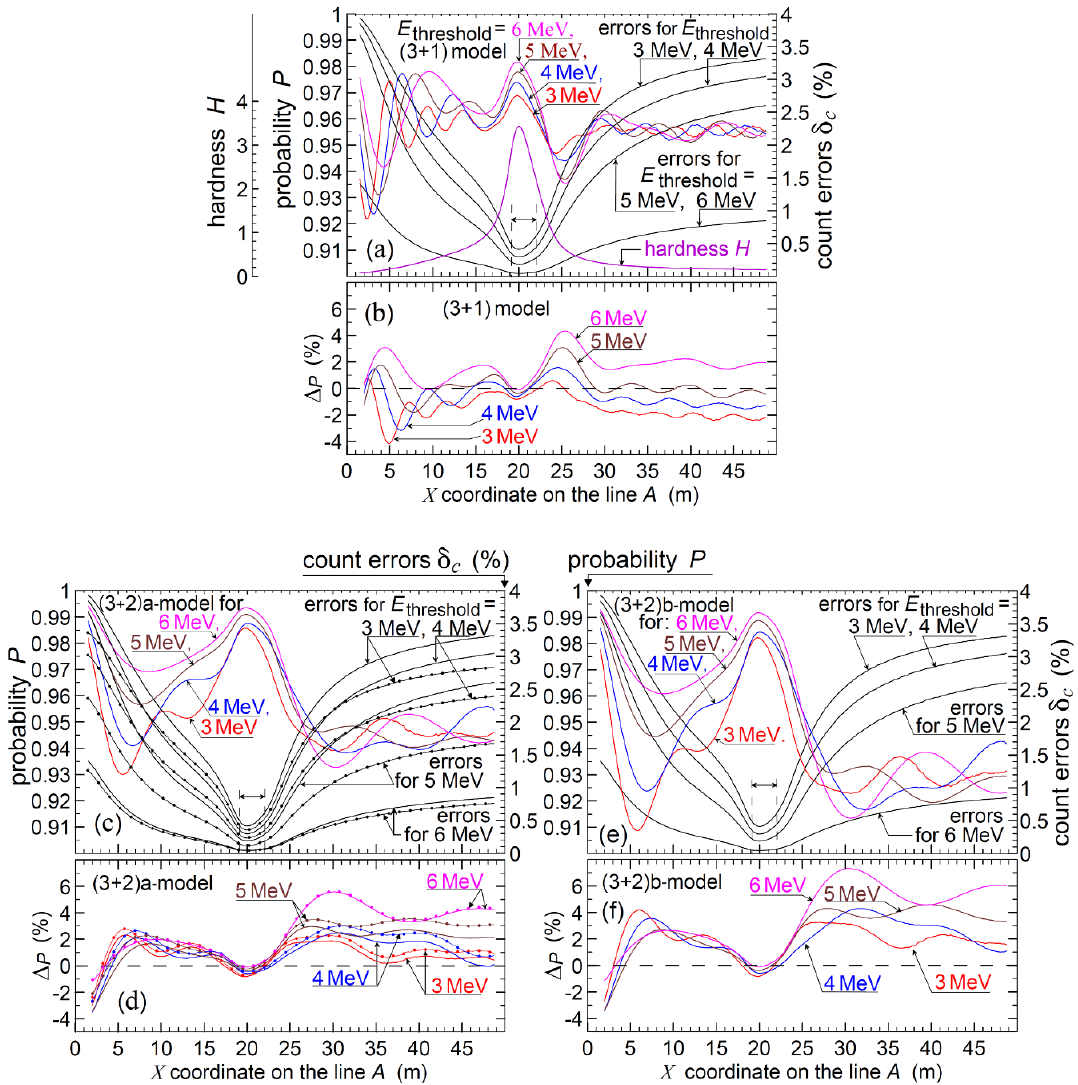
Figure 5 . Probability P of (cid:22) (cid:23) e -existence for three models ((3+1), (3+2)a and (3+2)b on the parts (a), (c) and (e)), count errors (cid:14) C (caused by uncertainties of AZ spectrum) (parts (a), (c) and (e)) and functional (cid:1) p ( x ) for opportunity of (cid:22) (cid:23) e -detecting (parts (b), (d) and (f) for three models (3+1), (3+2)a and (3+2)b) depending on the X -coordinate along line A (geometry of (cid:12)gure 3) at thresholds of registration E = 3, 4, 5 and 6 MeV (labeled at curves). Hardness H ( x ) of the total (cid:22) (cid:23) e -spectrum is presented in the part (a). The all solid lines correspond the values obtained for (cid:22) (cid:23) e -spectrum with bump taken into account. The curves with points ( (cid:14) C and (cid:1) p for model (3+2)a in parts (c) and (d)) | the data for spectrum without bump. Position of the reservoir is shown by the two-sided arrow on parts: (a), (c) and (e). X -coordinates of the positive functional (cid:1) p values are the regions where probability of (cid:22) (cid:23) e -detecting is higher to level of total spectrum errors.